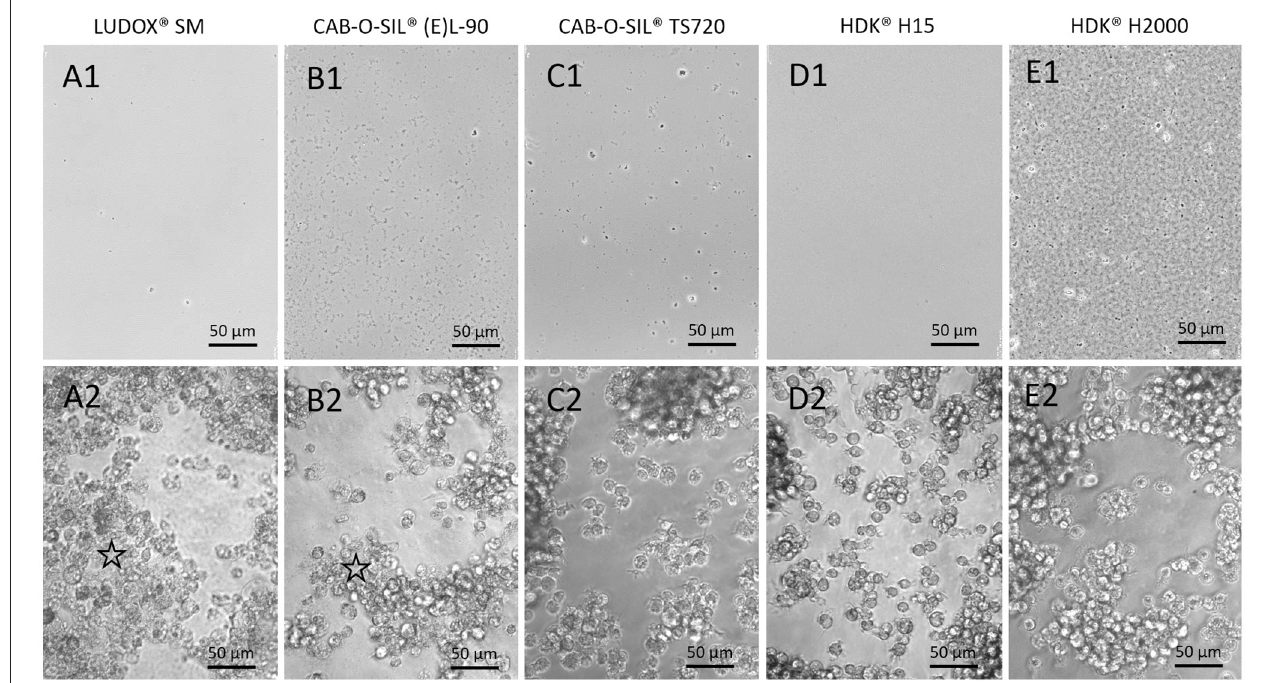
FIGURE 2 | Gravitational settling and uptake of selected SAS. Phase contrast images from cell culture experiments with 90 µ g/ml of indicated SAS in the absence (A1–E1, cell-free controls) and presence of NR8383 cells (A2–E2). (A,B) Untreated SAS dispersed with Protocol 2, (C–E) surface-treated SAS dispersed with